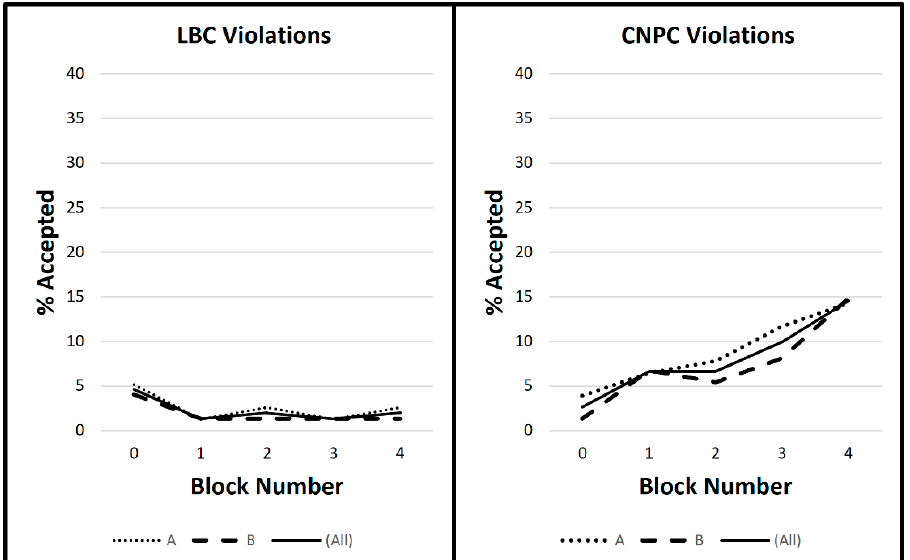
Figure 7. Comparison of LBC violations and CNPC violations in Experiment III.